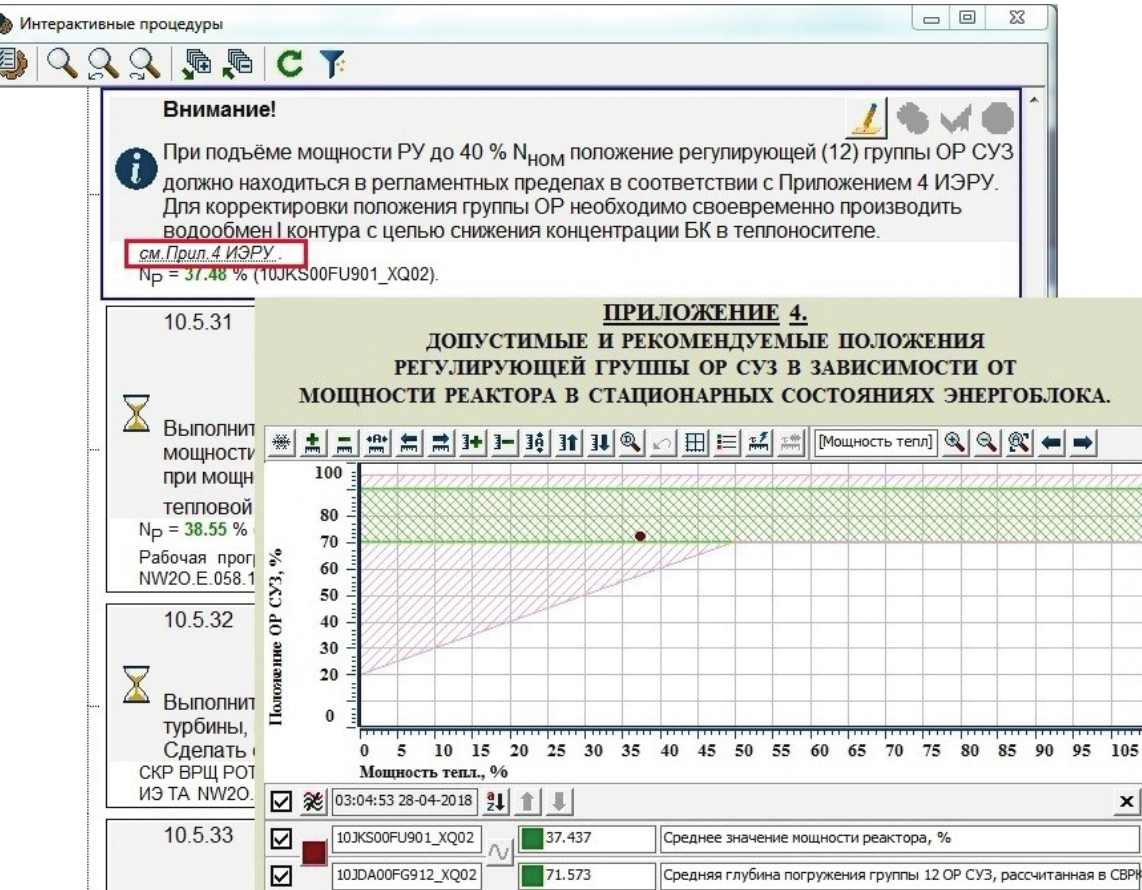
Figure 5. A sample link to operational